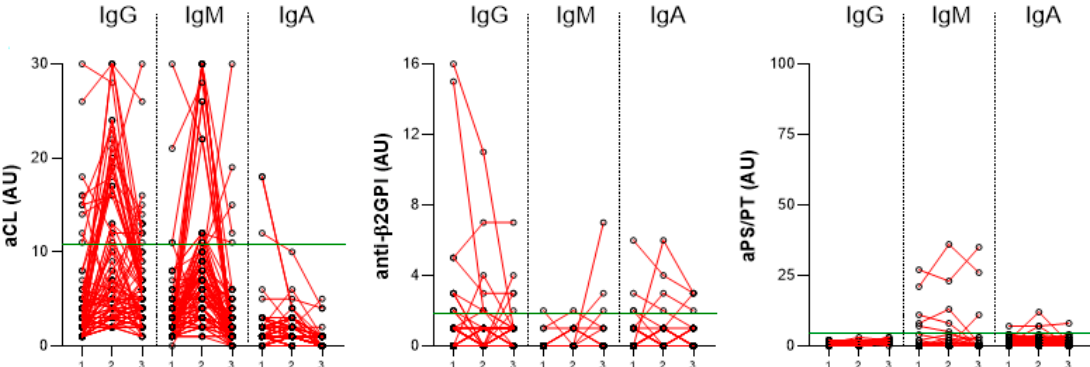
Figure 1. Longitudinal trends of aCL, anti- β 2GPI, and aPS/PT, IgG, IgM, and IgA during infection with SARS-CoV-2 in COVID-19 patients hospitalized in the non-ICU (group III) at three time points (1—at admission, 2—at hospital discharge, 3—at 3-month follow-up after hospital discharge). The red lines connect the aPL levels of the individual COVID-19 patients at three time points. Values above the green line (99th percentile of healthy blood donors) are considered positive.